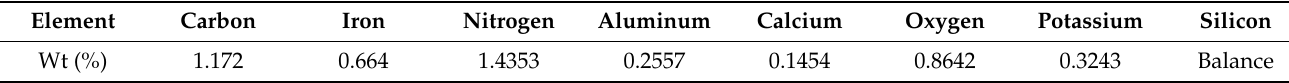
Table 2. Composition (Wt%) of SiC reinforcement particle